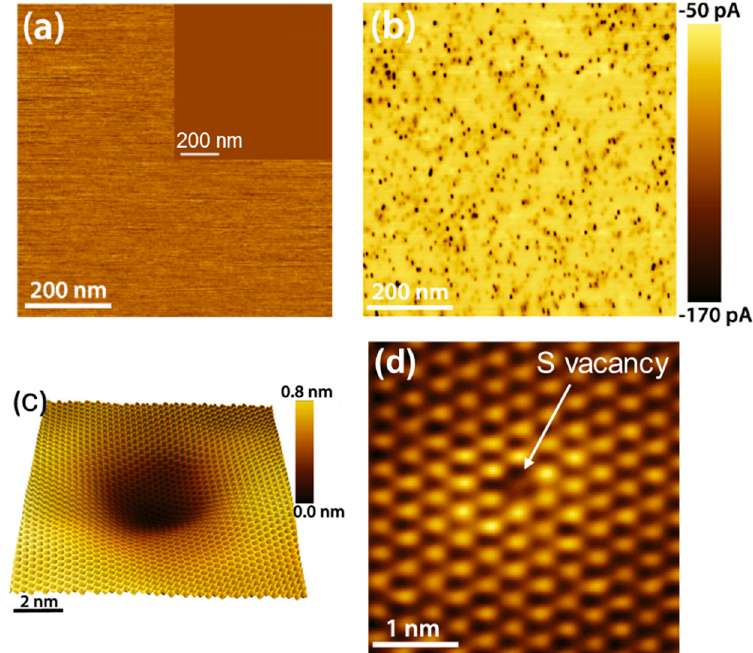
Figure 4. ( a ) Lateral force microscopy (LFM) and topography (insert) image of the MoS 2 surface. ( b ) Simultaneously recorded C-AFM image. ( c ) Scanning tunneling microscopy (STM) image of a subsurface defect, corresponding to one of the high current spots in the panel ( b ). ( d ) STM image of a sulfur vacancy in the outermost sulfur layer. Images adapted with permission from Reference [45], copyright from the American Chemical Society 2017.